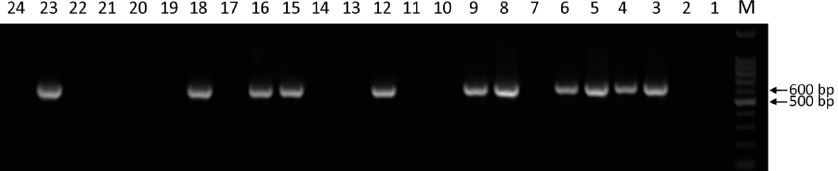
Figure 4. Electrophoretic analysis of PCR amplification products of a putative cry2A gene for transgenic sugarcane plants: M, DNA Marker; 1, Blank control of ddH 2 O; 2, Negative control (non-transgenic sugarcane without bombardment); 3, Positive control (plasmid pGcry2A0229); 4–24, Herbicide Basta-resistant plants.